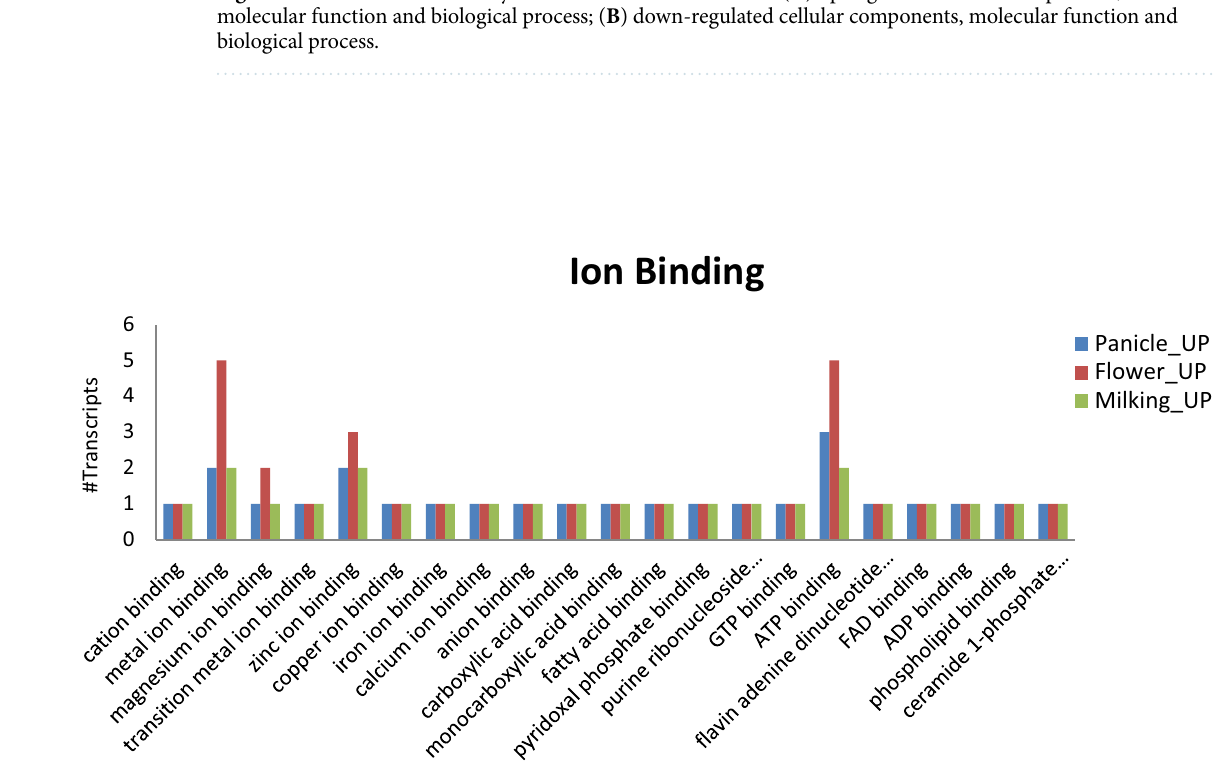
Figure 3. Classification of ion binding component of molecular function which were up-regulated during the three different stages of panicle development i.e. panicle initiation, flowering stage and milking